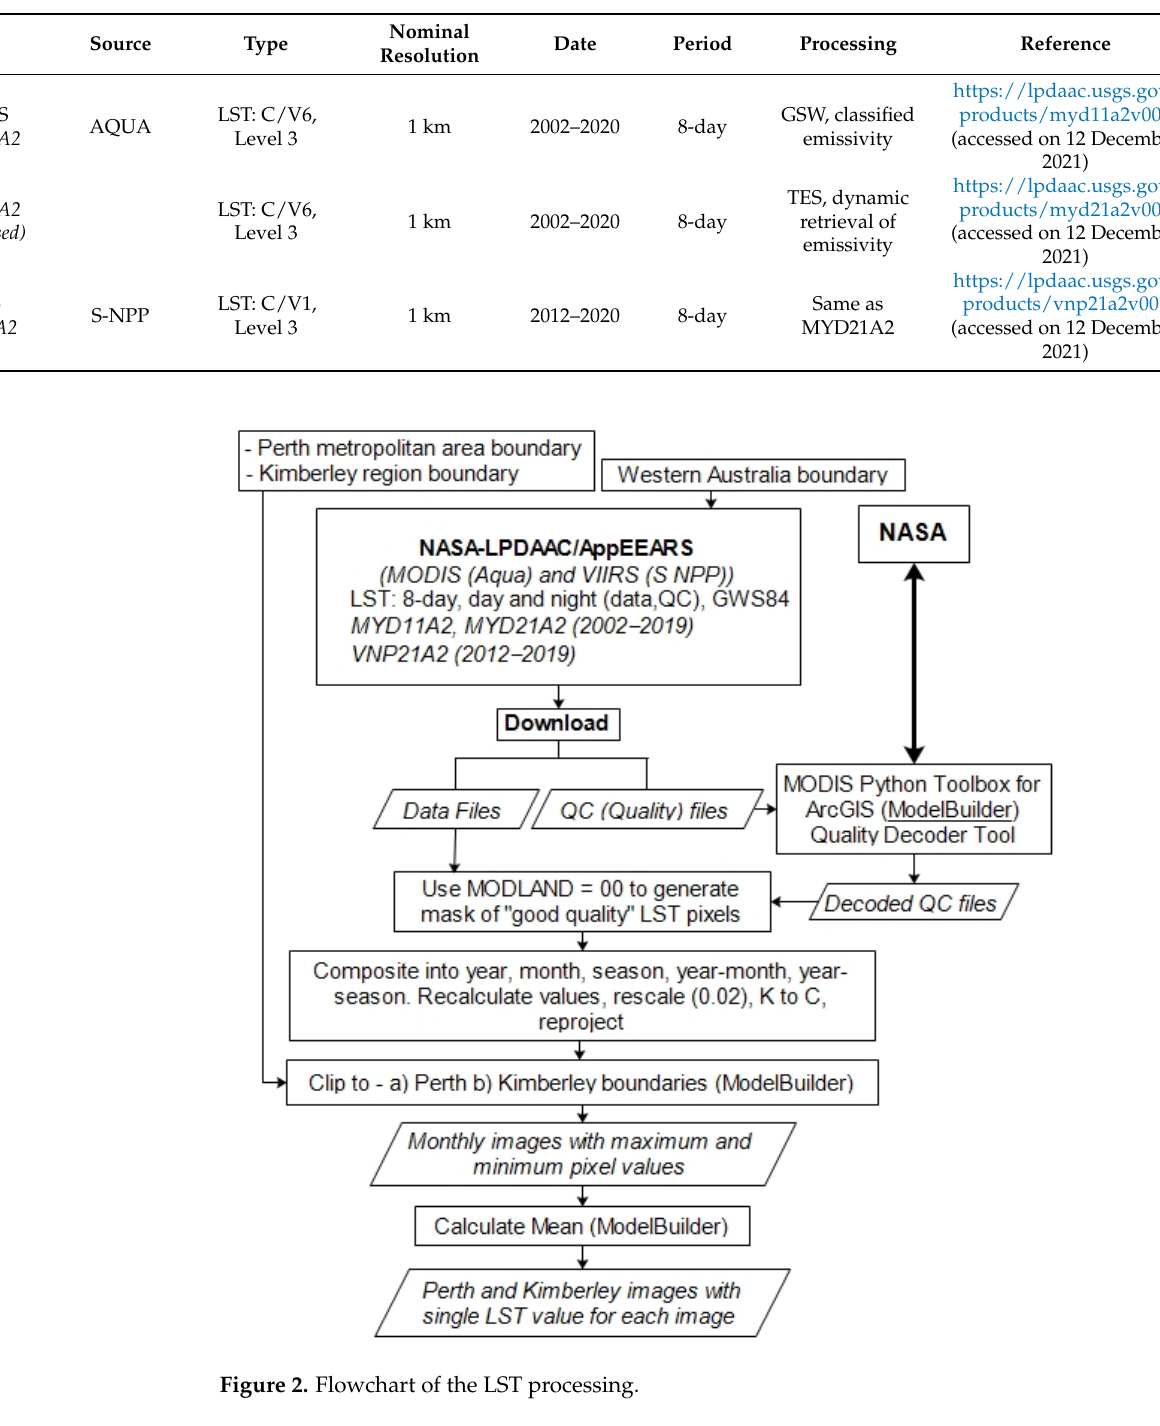
Table 1. Summary of all data obtained for this study.